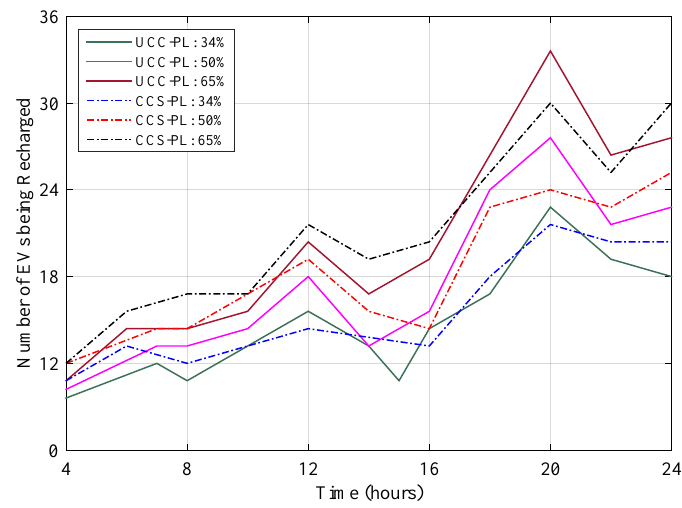
Figure 10. EV charging pattern during a typical day of August.